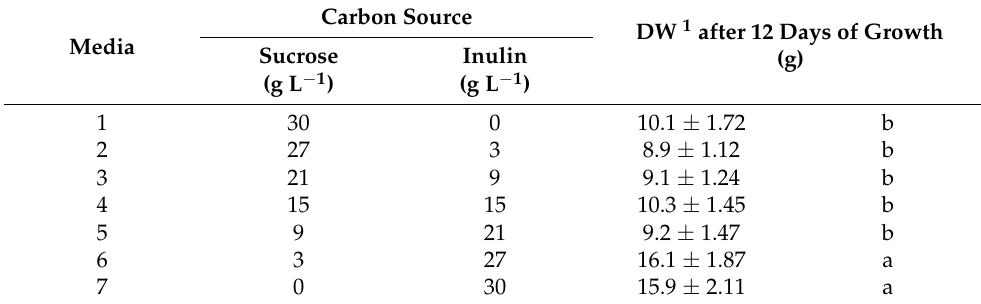
Table 3. Mycelial yield in liquid media by adding different concentrations of sucrose and inulin.